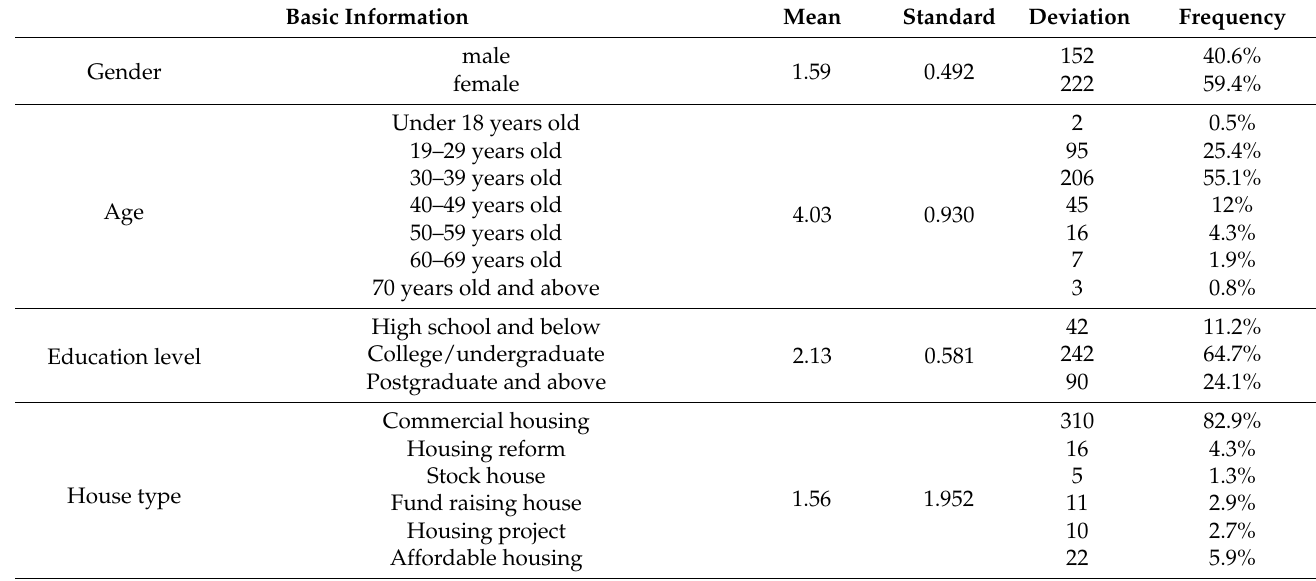
Table 3. Descriptive statistical analysis of